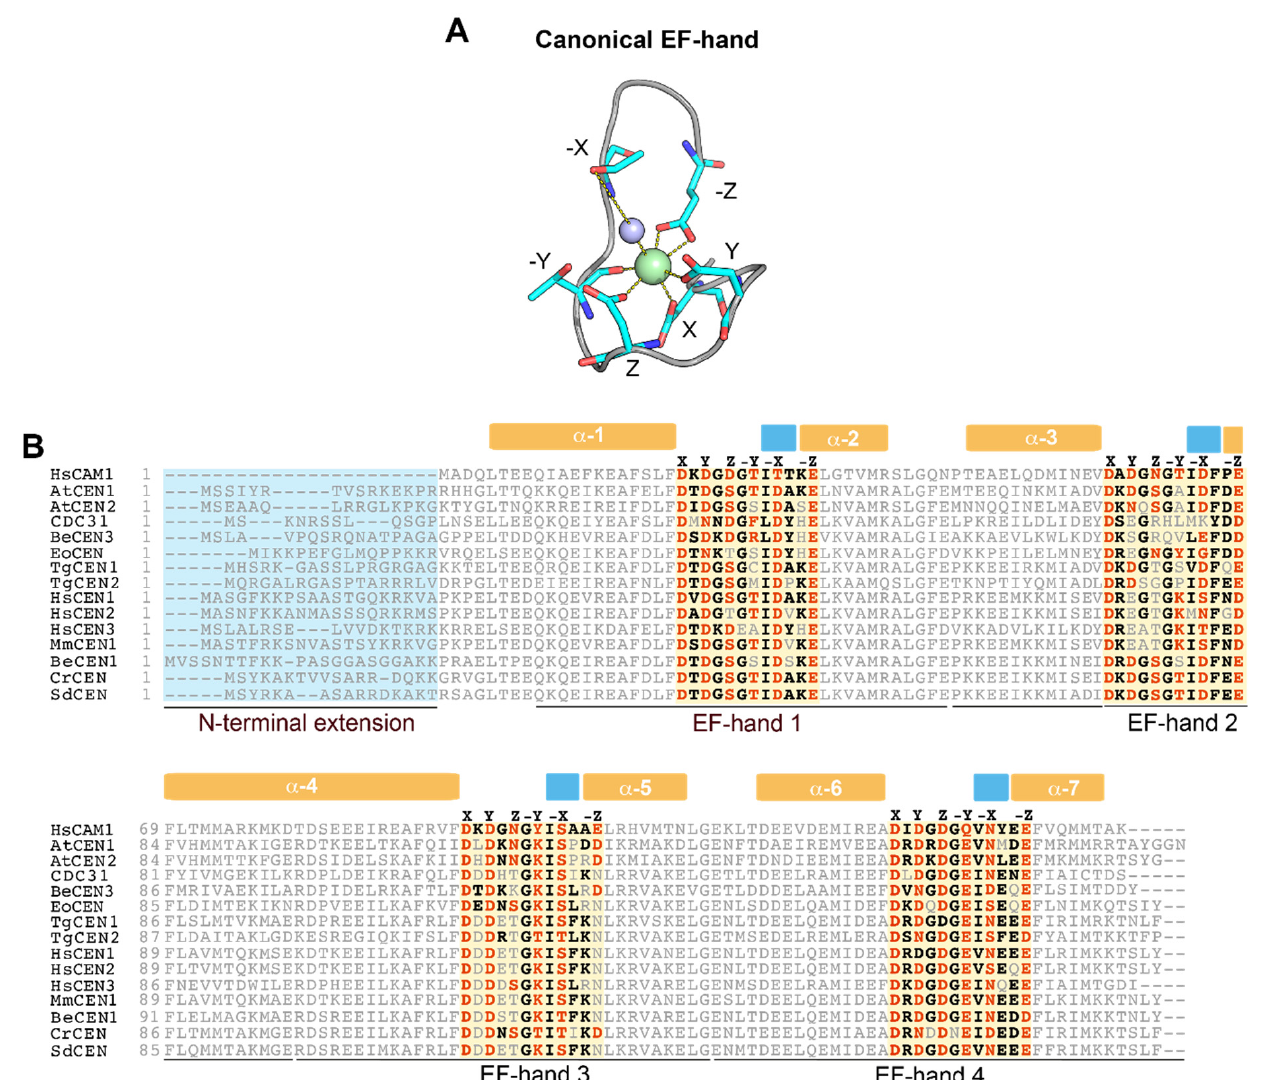
Figure 1. Overview of the EF-hand Ca 2+ binding domains in different centrins. ( A ) Ca 2+ coordination by the canonical EF-hand (PDB: 1CLL). The Ca 2+ ion is coordinated in a pentagonal bipyramidal configuration by ligands indicated by their position in the coordination geometry (X, Y, Z, − X, − Y and − Z). NH groups of coordinating amino acids are indicated in dark blue, oxygen atoms in red, the Ca 2+ ion in green and the coordinating water molecule in violet. ( B ) Protein sequence alignment of centrins from different organisms. The N-terminal extension (light blue box) and the central 12 residues in the EF-hand domains (orange boxes) are highlighted. Within the EF-hands, Ca 2+ chelating residues are represented in orange while the other most common residues are represented in black. Secondary structural elements derived from the 3D structure of human CaM (PDB: 1CLL), α -helices (orange) and β -sheets (light blue) are displayed on the top of the alignment.